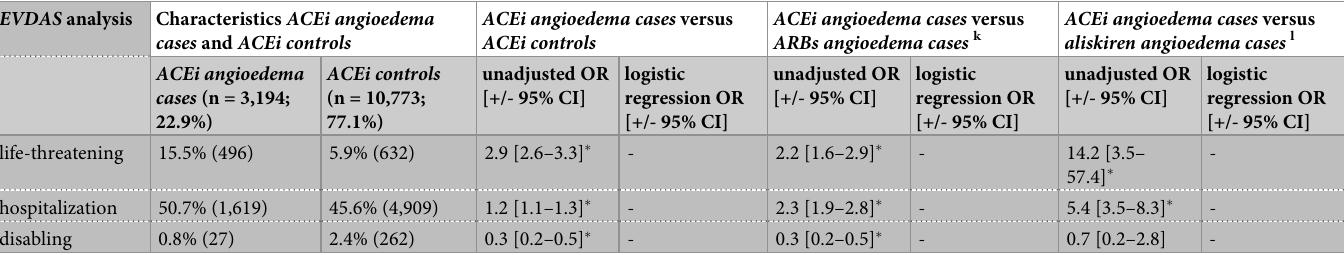
Table 1. (Continued) EVDAS analysis Characteristics ACEi angioedema cases and ACEi